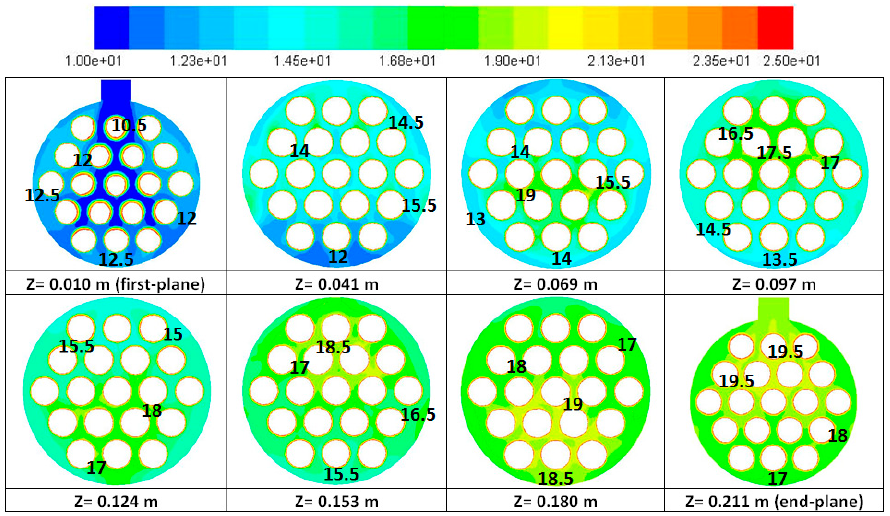
Figure 10. Prediction of temperature (°C) distribution at section planes defined in shell side (Case-I).